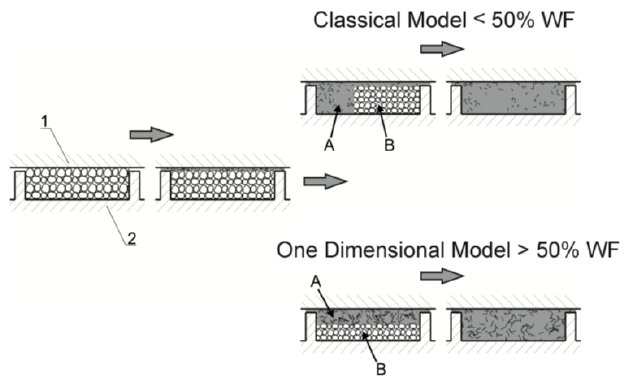
Figure 7. Geometrical model of melting mechanism of wood – plastic composites (WPC) in the single-screw extruder with dependence on wood flour (WF) content: 1 — barrel, 2 — screw, A — molten single-screw extruder with dependence on wood flour (WF) content: 1—barrel, 2—screw, A—molten material, B — solid material. material, B—solid